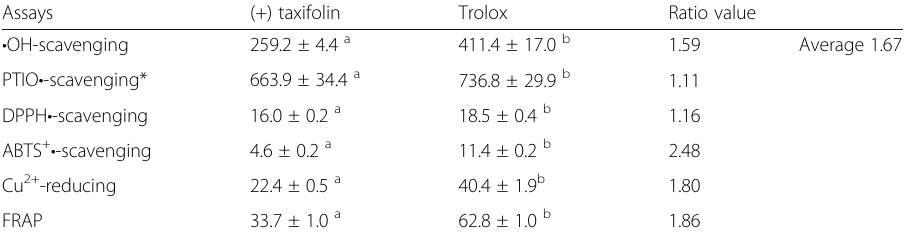
Table 1 The IC 50 values of (+) taxifolin and trolox in various assays ( μ M)